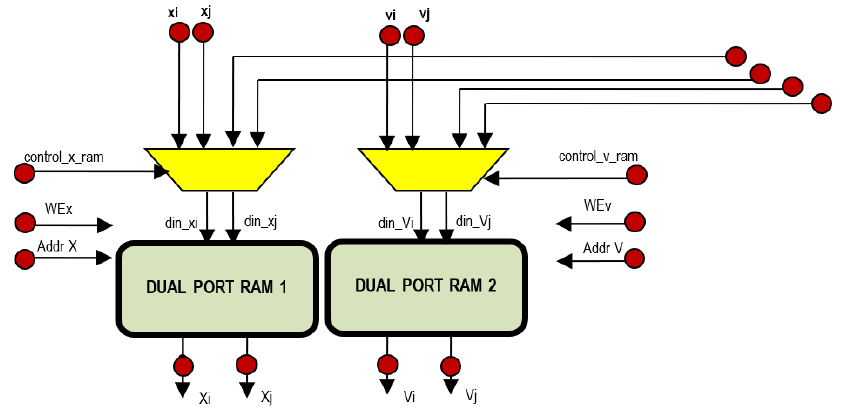
Figure 12. Dual Port Ram 1 and